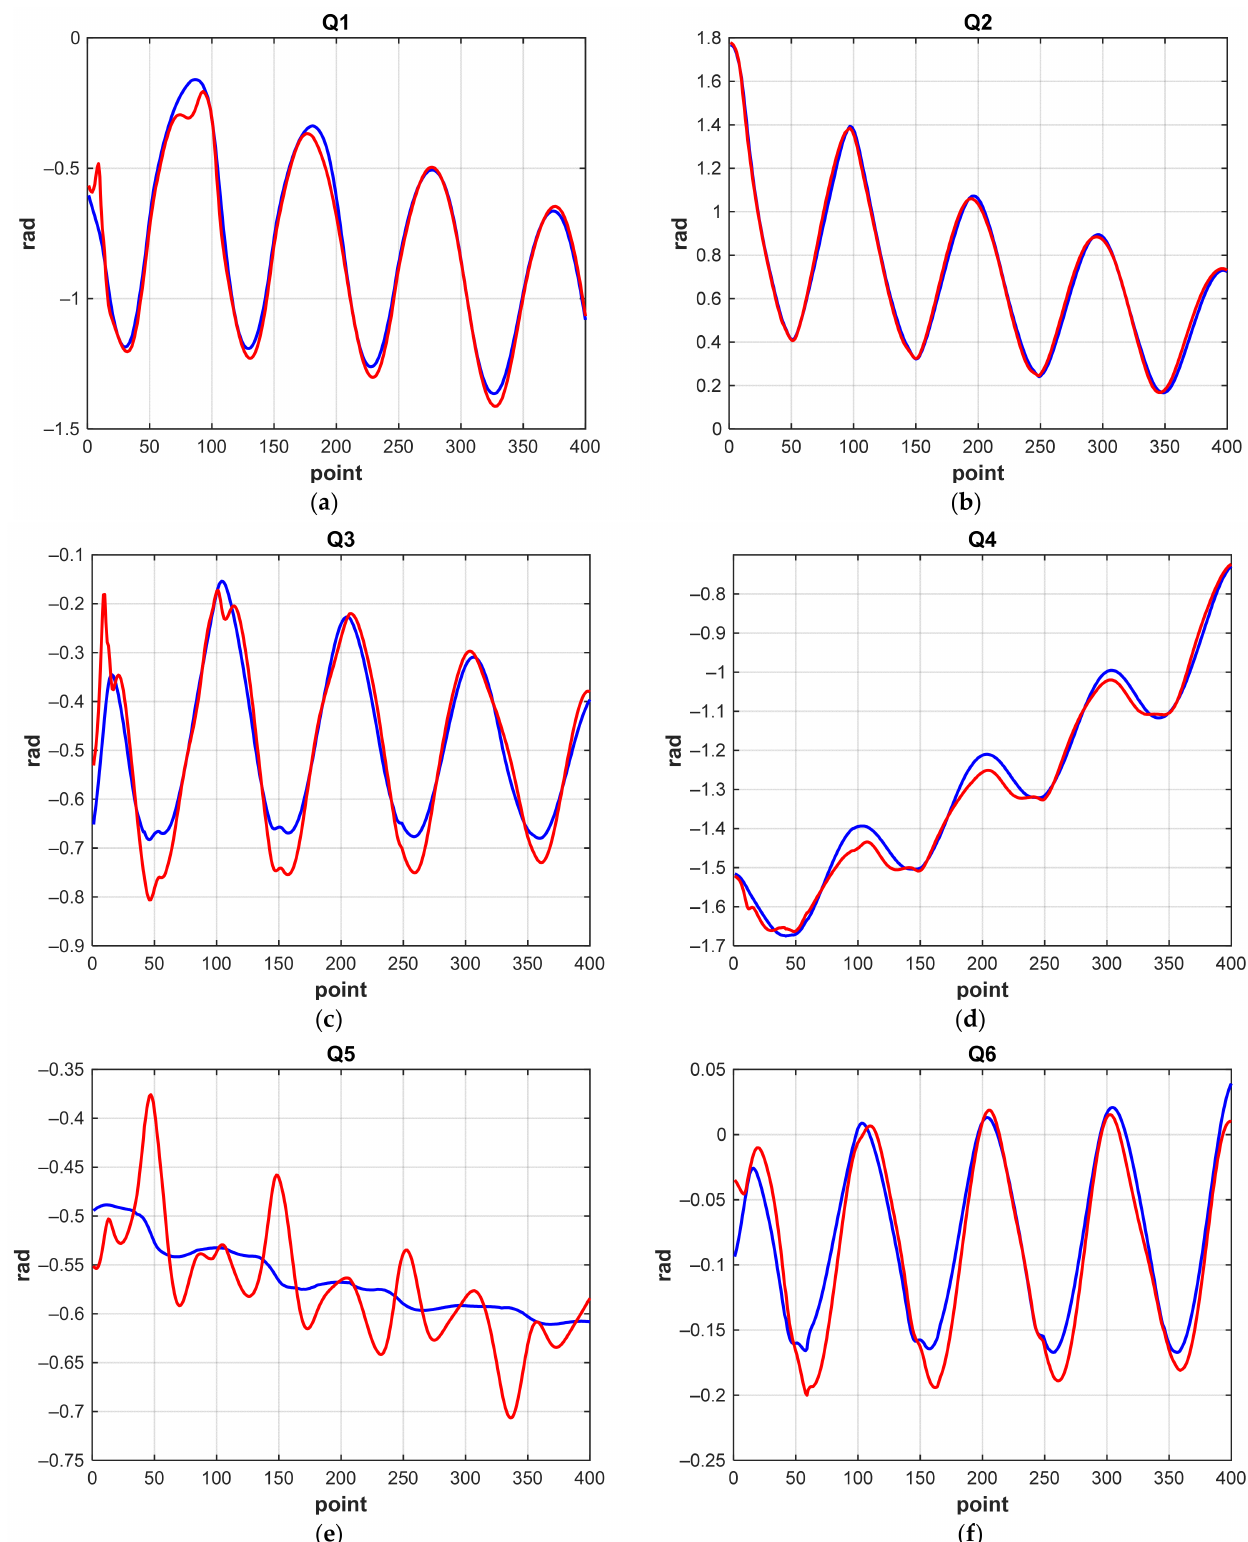
Figure 21. Graphs of changes in generalized coordinates when the manipulator moves along a 3D spiral (MATRIX NN 1): ( a ) q1; ( b ) q2; ( c ) q3; ( d ) q4; ( e ) q5; ( f )